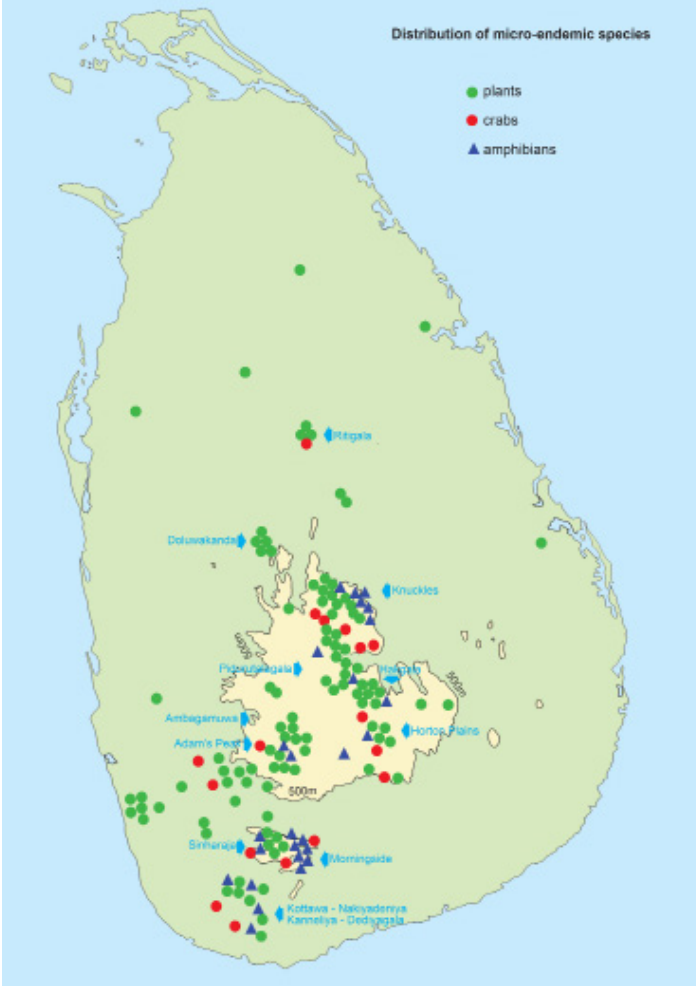
Figure 1: The distribution of micro-endemic vascular plants, amphibians and freshwater crabs in Sri Lanka. Data for plants from Dassananayke and Fosberg (1980-2006) and for amphibians and freshwater crabs from the respective collections in the National Museum of Sri